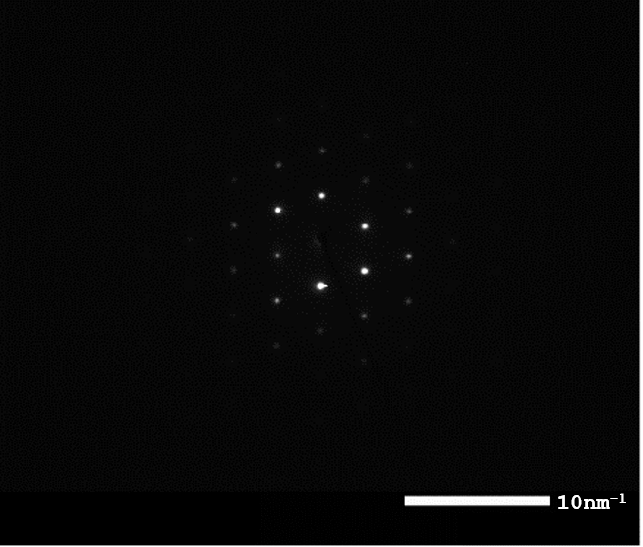
Figure 5. X-ray di ff ractogram of the HfCN coating.